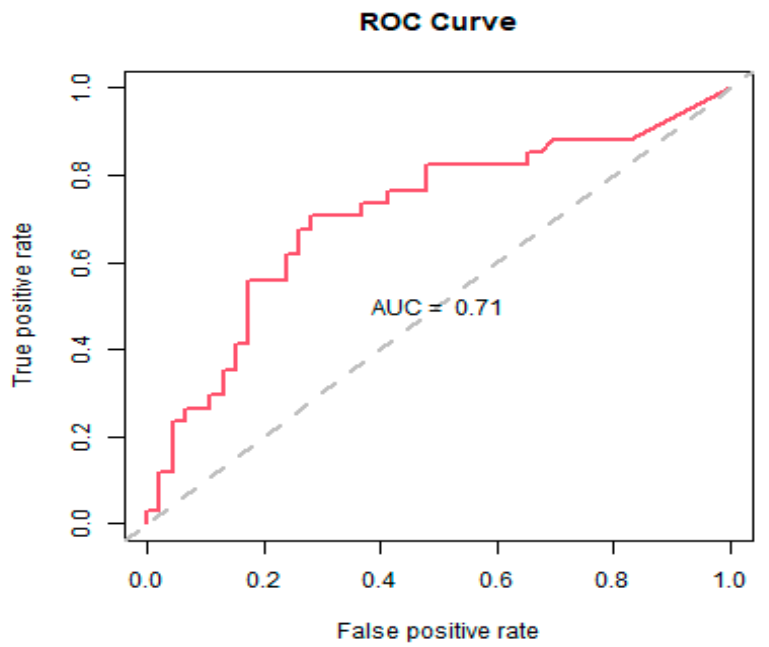
Figure 4. Receiver operator characteristic (ROC) chart plots the true positive classification rate against the false positive classification rate at different probability cutoff thresholds. The area under the curve (AUC) is an aggregate measure of performance across all possible classification thresholds.